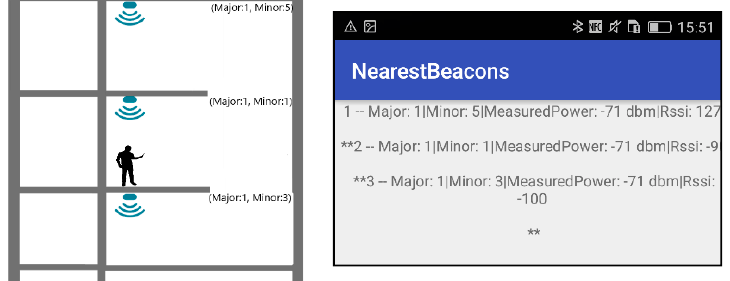
Figure 5. Test configuration in mezzanine (a green region in Figure 3) and a screen print of the corresponding NearestBeacons App.